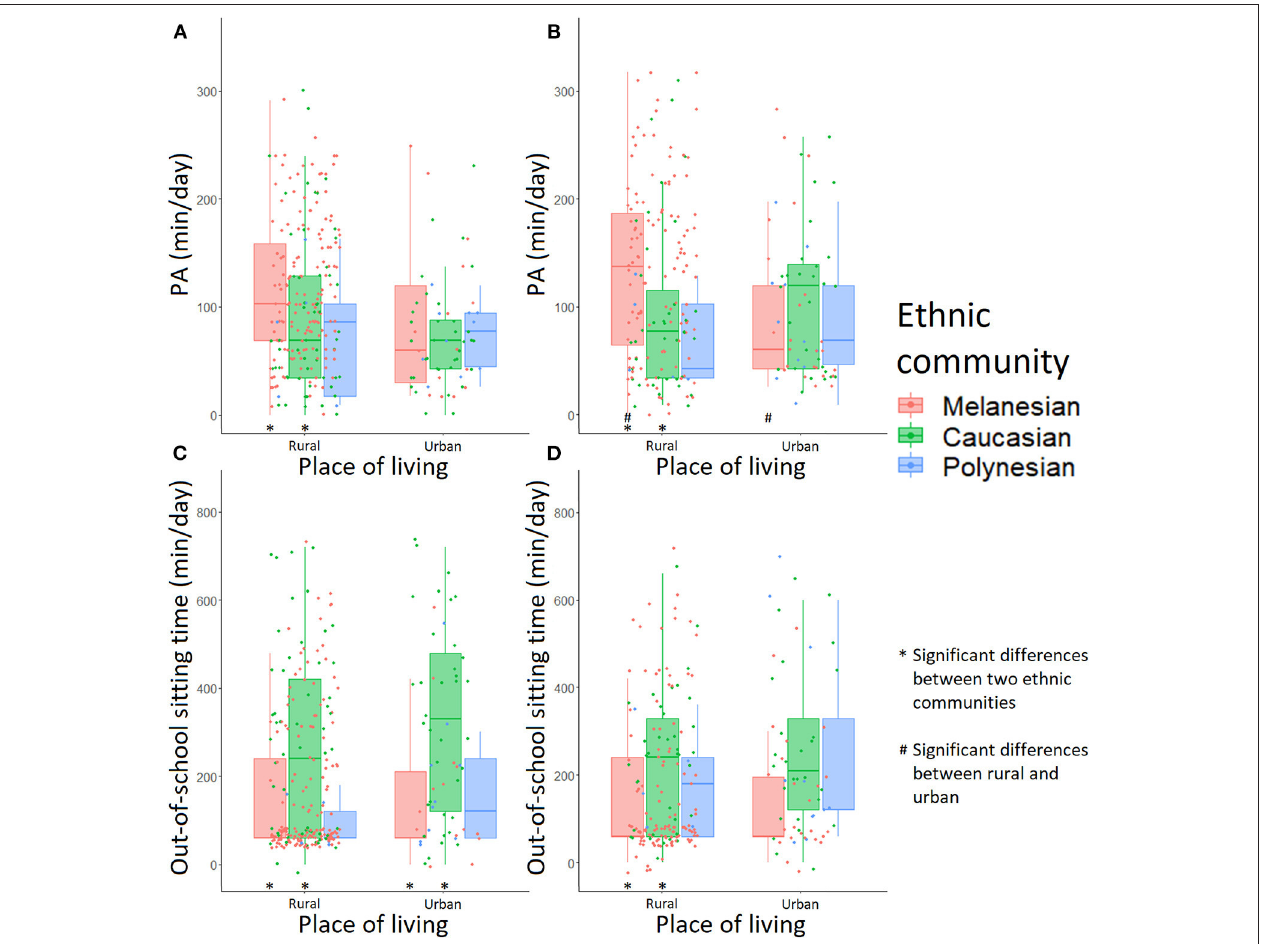
FIGURE 2 | Time spent in physical activity and sitting time in adolescents according to ethnic community and place of living: (A) PA in female adolescents, (B) PA in male adolescents, (C) out-of-school sitting time in female adolescents and (D) out-of-school sitting time in male adolescents. A “*” note means a significant difference between two ethnic communities in a single place of living; a “#” note means a significant difference between rural and urban environment in a single ethnic